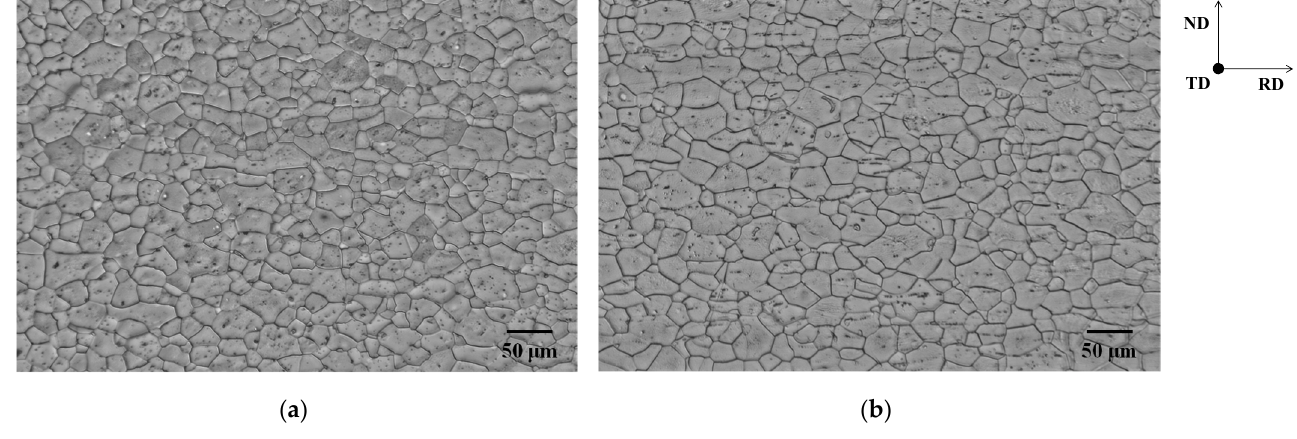
Figure 5. Optical micrographs of specimens ( a ) A and ( b ) B heated to 1073 K.